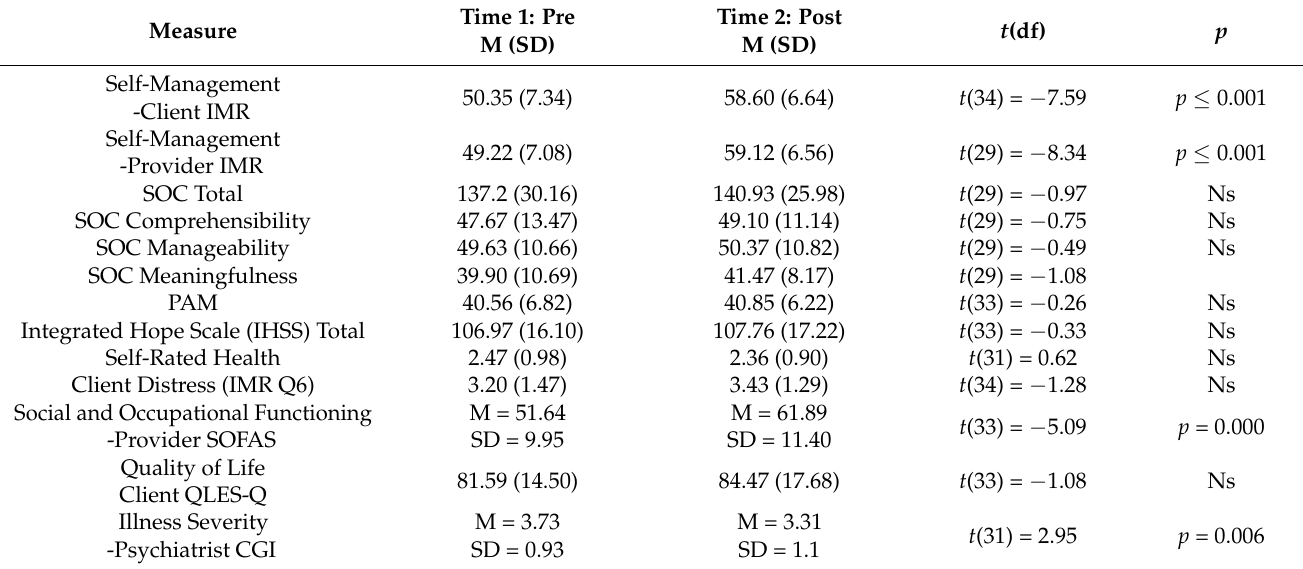
Table 3. Pre–Post SET for Health Changes in Clinical and Functional